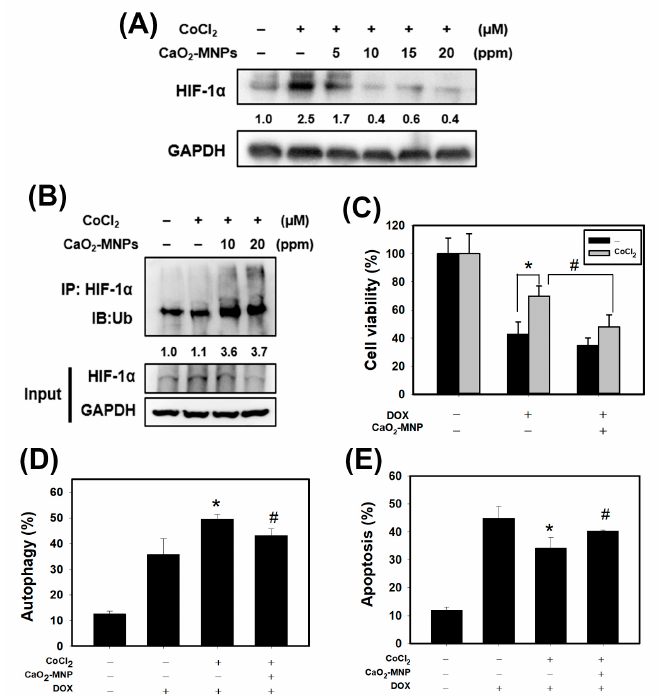
Figure 5. CaO 2 -modified MNPs cause protein degradation and ubiquitination of hypoxia-inducible factor 1 α (HIF-1 α ), and reverts the effects of DOX on apoptosis and autophagy in 4T1 cells. ( A ) Western blot analysis for HIF-1 α protein expression. Cells were incubated with CoCl 2 (100 µ M) for 24 h, treated with CaO 2 -MNPs for 24 h, then harvested for protein extraction and then subjected to western blot analysis. ( B ) immunoprecipitation (IP) assay for HIF-1 α ubiquitination. 4T1 cells incubated with CoCl 2 (100 µ M) for 24 h and treated with CaO 2 -MNPs for 24 h. The total protein lysates harvested from 4T1 cells were immunoprecipitated with anti-HIF-1 α antibody. The complexes and the input were examined using western blot analysis with anti-ubiquitin antibody. Effect of CaO 2 -MNPs on cell viability ( C ), autophagy ( D ) and apoptosis ( E ) of 4T1 cells. Cells were pretreated with CoCl 2 (100 µ M) for 8 h, treated with CaO 2 -MNPs (20 ppm) for 16 h, then incubated with DOX (1 µ M) for 24 h. * p < 0.05 DOX alone compared with DOX + CoCl 2 . # p < 0.05 DOX + CoCl 2 compared with DOX + CoCl 2 + CaO 2 -MNPs.